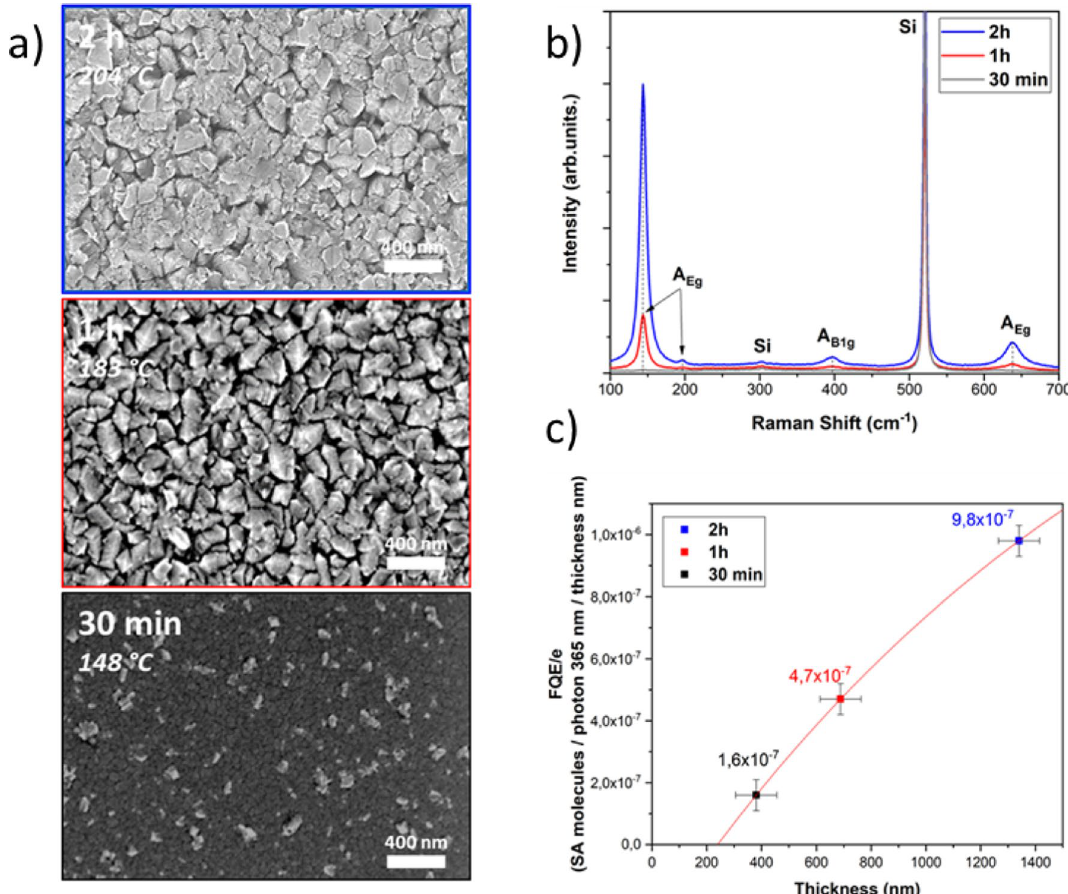
Figure 4. : SEM topviews with associated T sub max ( a ), Raman scattering spectra ( b ) and Photocatalyic activity normalized to the thickness ( c ) of TiO 2 thin films deposited for different time (CW mode at 500